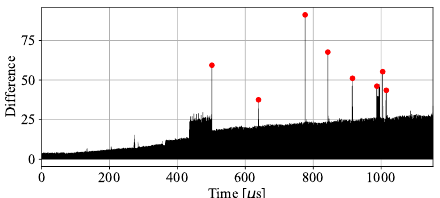
detection. Template matching is applied only to the section where the trigger is at high level (cf. Figure 10). Figure 21: Template matching